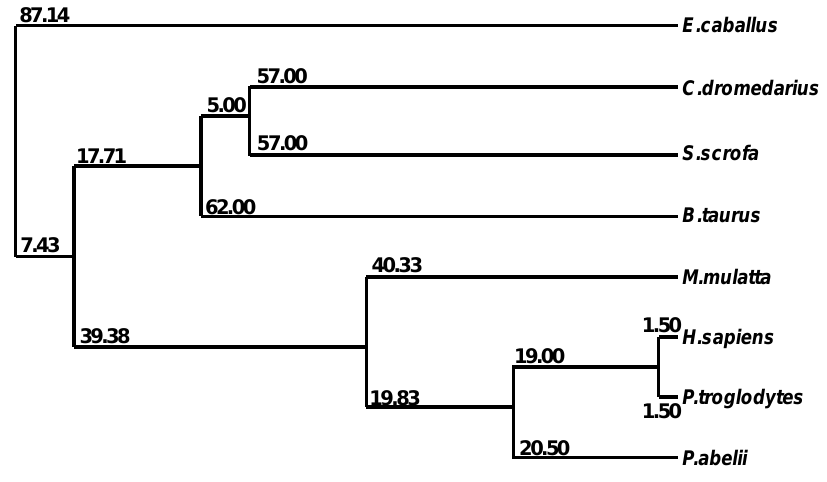
Figure 4. The phylogenetic tree of cSOD1 and potentially related genes. The protein sequence of Camel SOD1 was compared with other mammalian sequences of the GenBankTM data base. The alignment was generated with the BLOSUM62 from MAFFT Multiple Sequence Alignment [34,36]